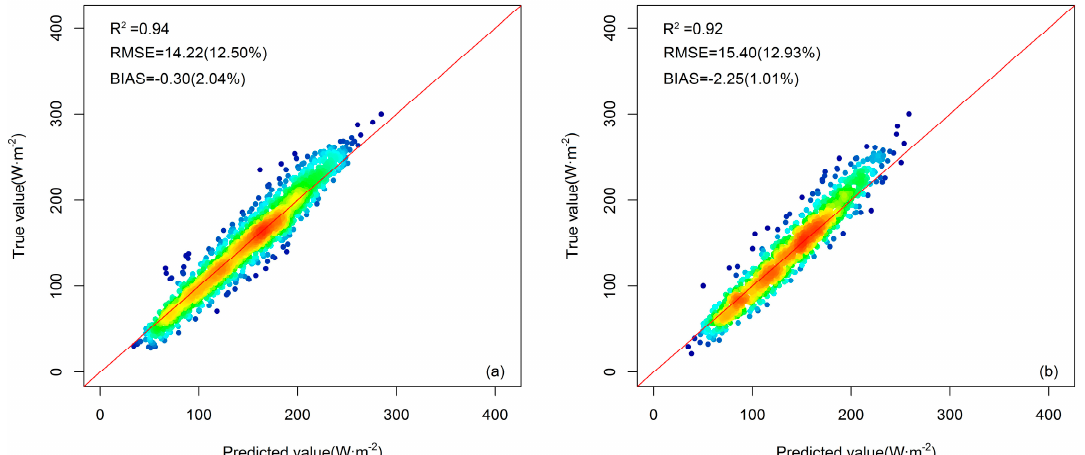
Figure 9. ( a ) Evaluation results of the training set’s estimated monthly mean DSR based on the GBRT-based DSR model against ground measurements in 2001 and 2002. ( b ) Evaluation results of the validation set’s estimated monthly mean DSR based on the GBRT-based DSR model against ground measurements in 2003. The number in the parentheses is the percent bias or RMSE value.